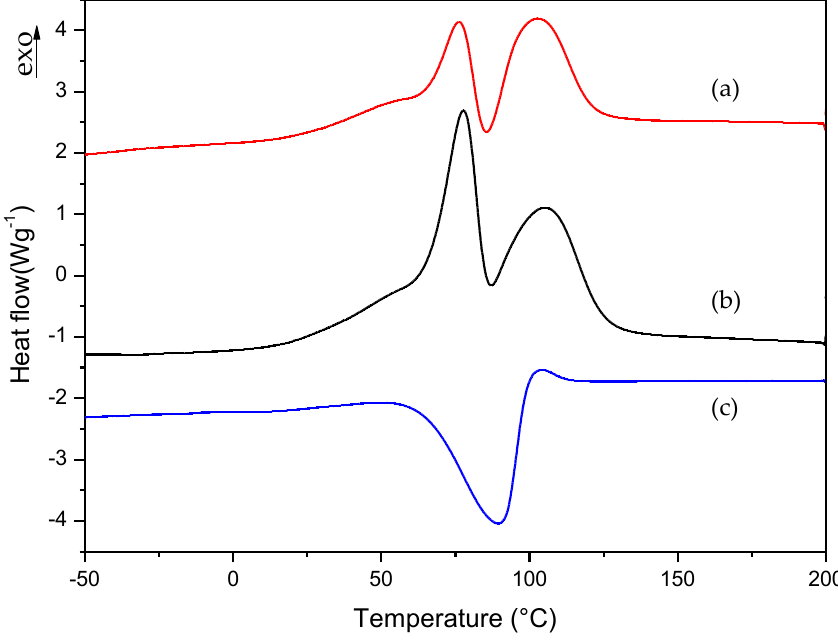
Figure 5. Dynamic DSC curves for curing process of (a) commercial, (b) A and (c) EMA formulations.